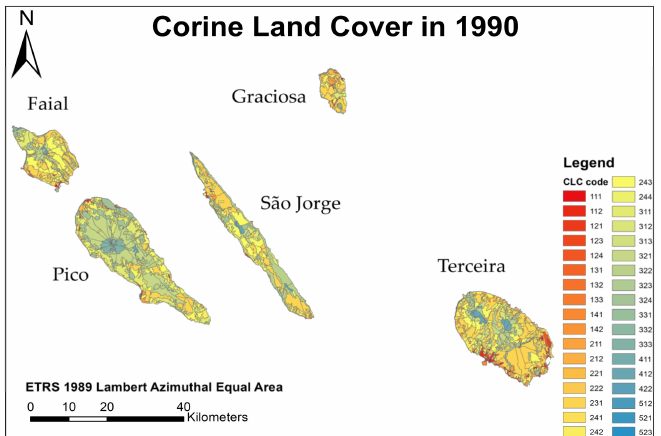
Figure A3. Thematic cartography regarding the land-use changes in the Central Group of Azores Archipelago in the year 1990.